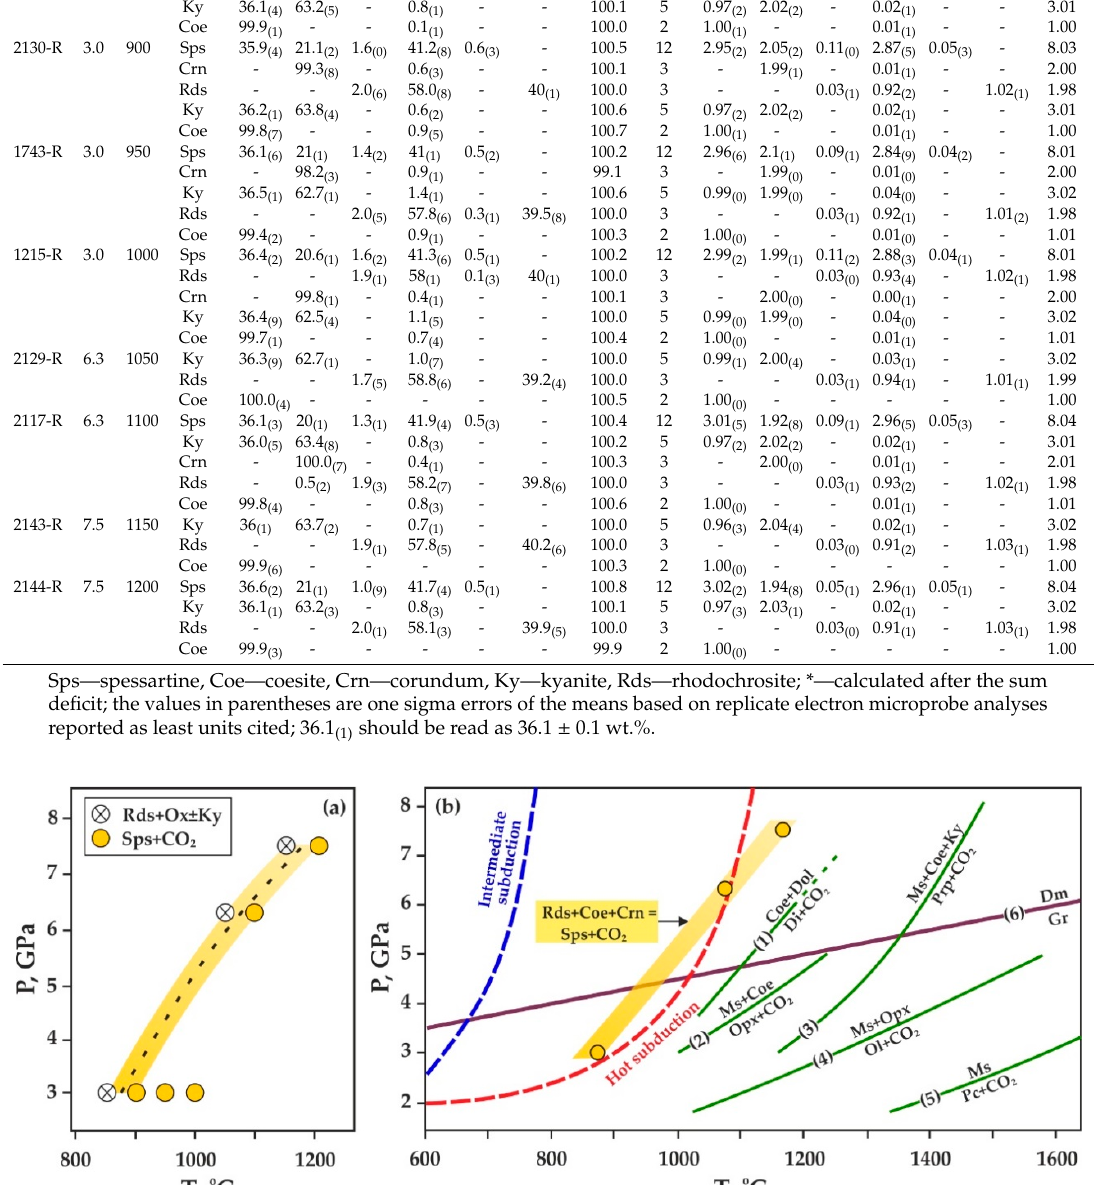
Table 2. Averaged compositions of spessartine, kyanite, rhodochrosite, and oxides after experiments. P, T , Run ◦ C Phase N GPa 2131-R 3.0 850